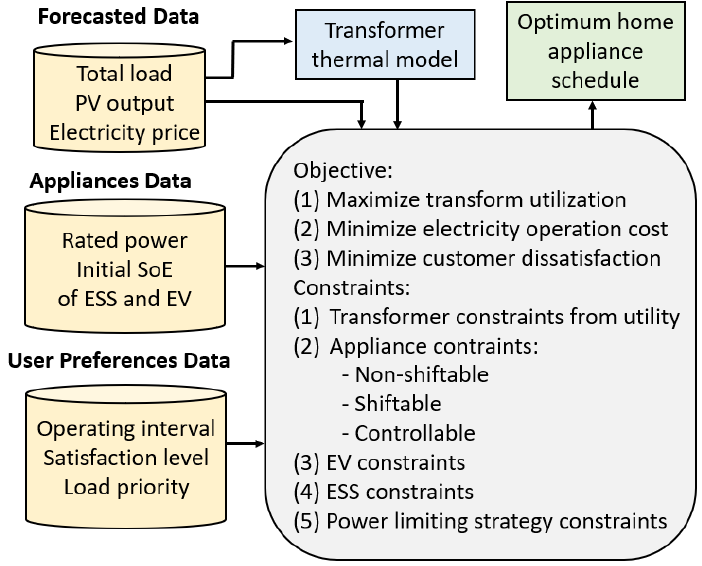
Figure 2. The proposed multi-objective HEMS-DR structure.